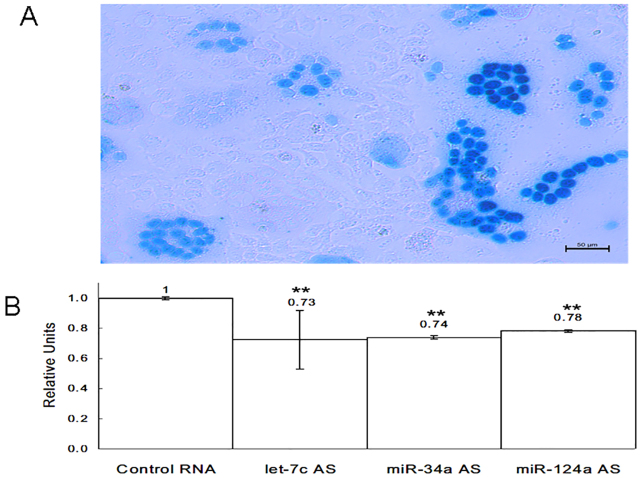

Overexpression of miRNA inhibitors reduces HIV-1 viral replication.(A) Representative picture of X-gal-stained HeLa-CCR5 cells infected with HIV-1. The photograph was taken using light microscopy. (B) The data represent the number of relative units (blue cells) counted in AntagoMiR-overexpressing wells relative to control sequence wells [miR antisense (AS):scrambled sequence]. Data show the mean±s.e.m. (n = 3); **P<0.005 (paired Student's t-test).